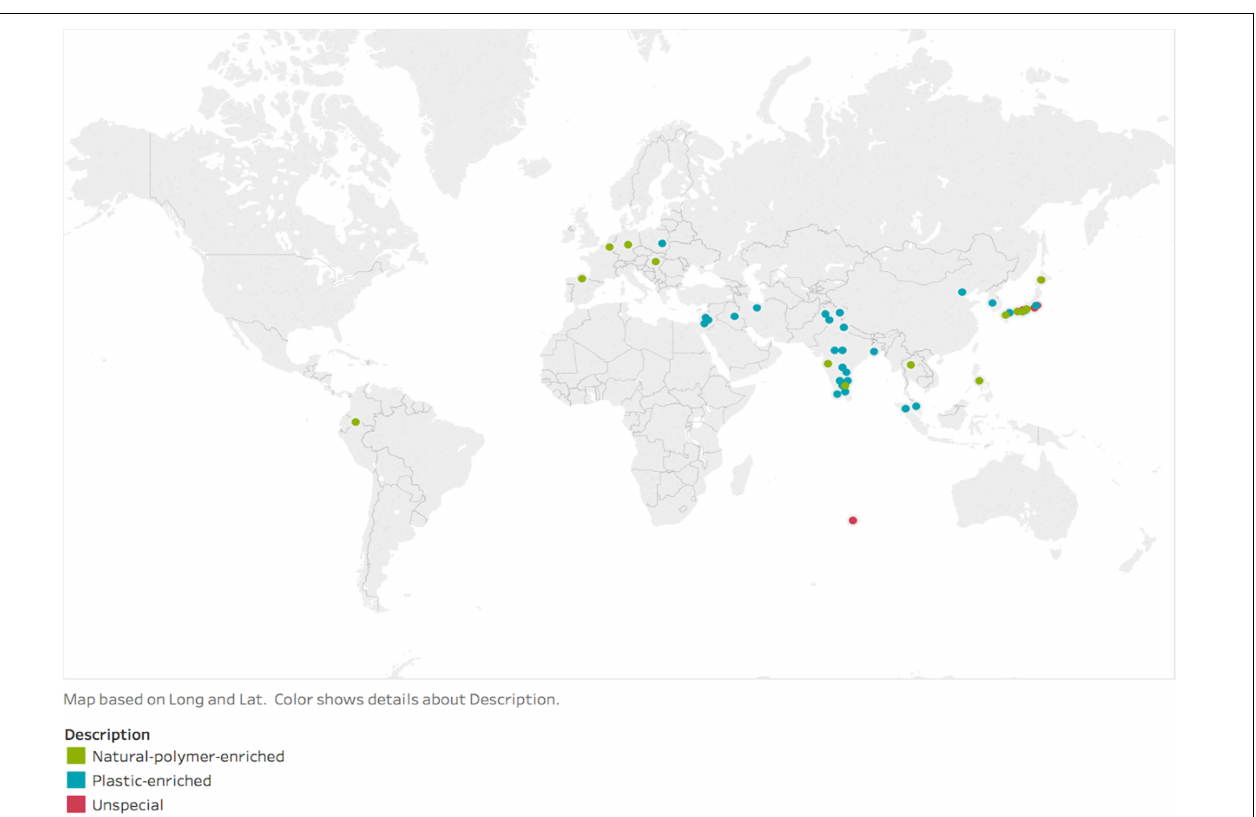
FIGURE 3 | The exploration of plastic-biodegrading organisms is concentrated in Japan and India. Much of the world remains